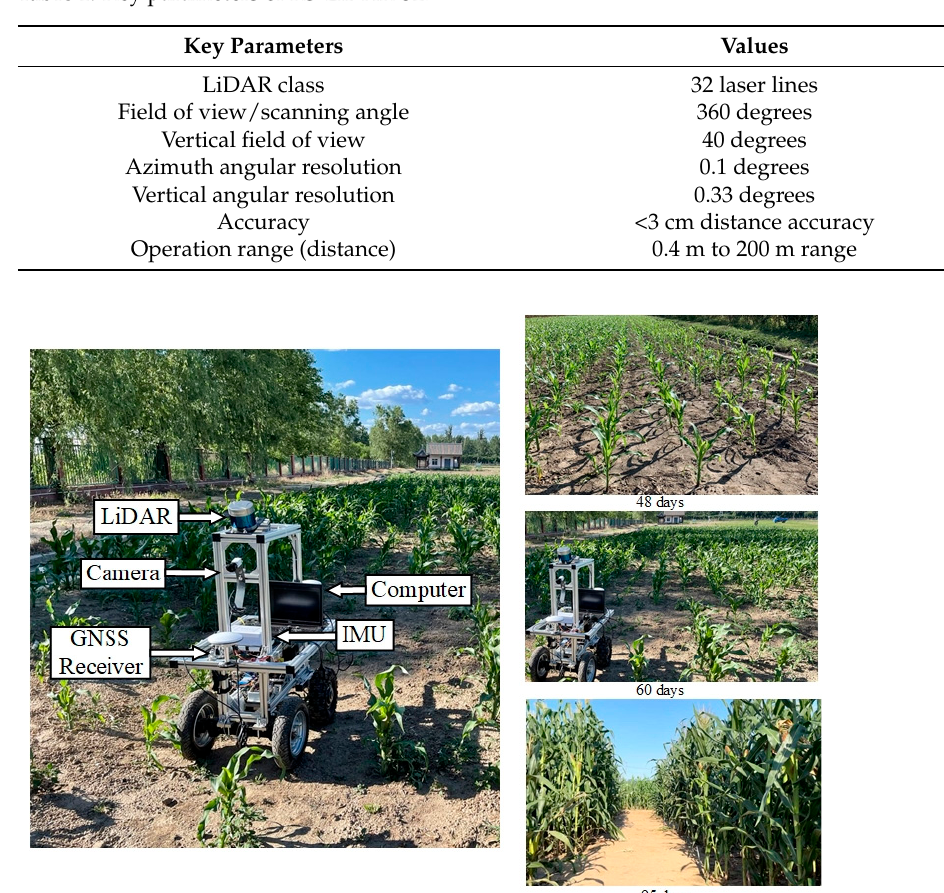
Table 1. Key parameters of RS-LiDAR-32.